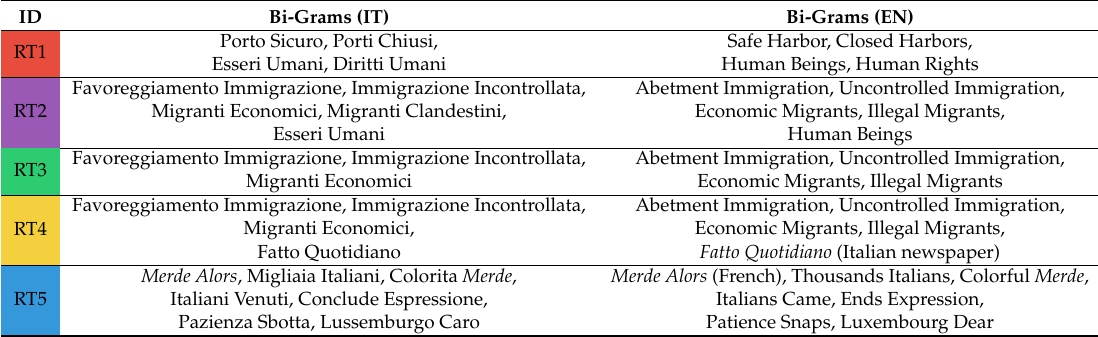
Table 6. Bi-grams characterising the communities. There is a clear alignment between communities RT2-3-4. RT5 stands out, mostly quoting a speech from the Ministry of Interior of Luxembourg. RT1 looks like the only cluster with a positive stance towards